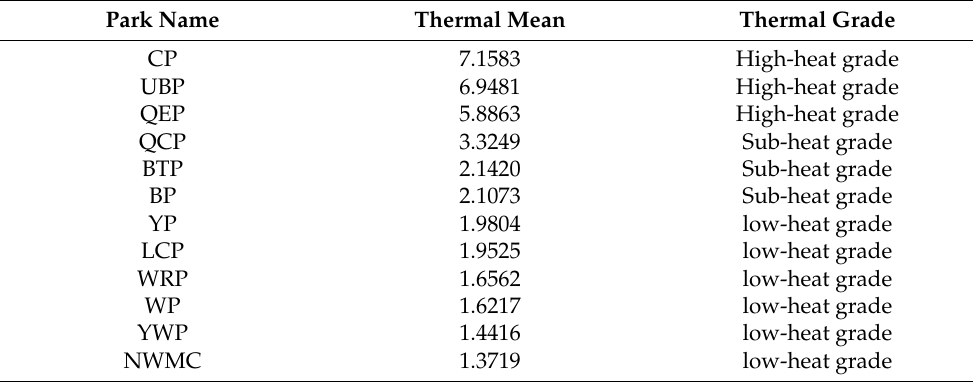
Table 7. Park thermal value data.